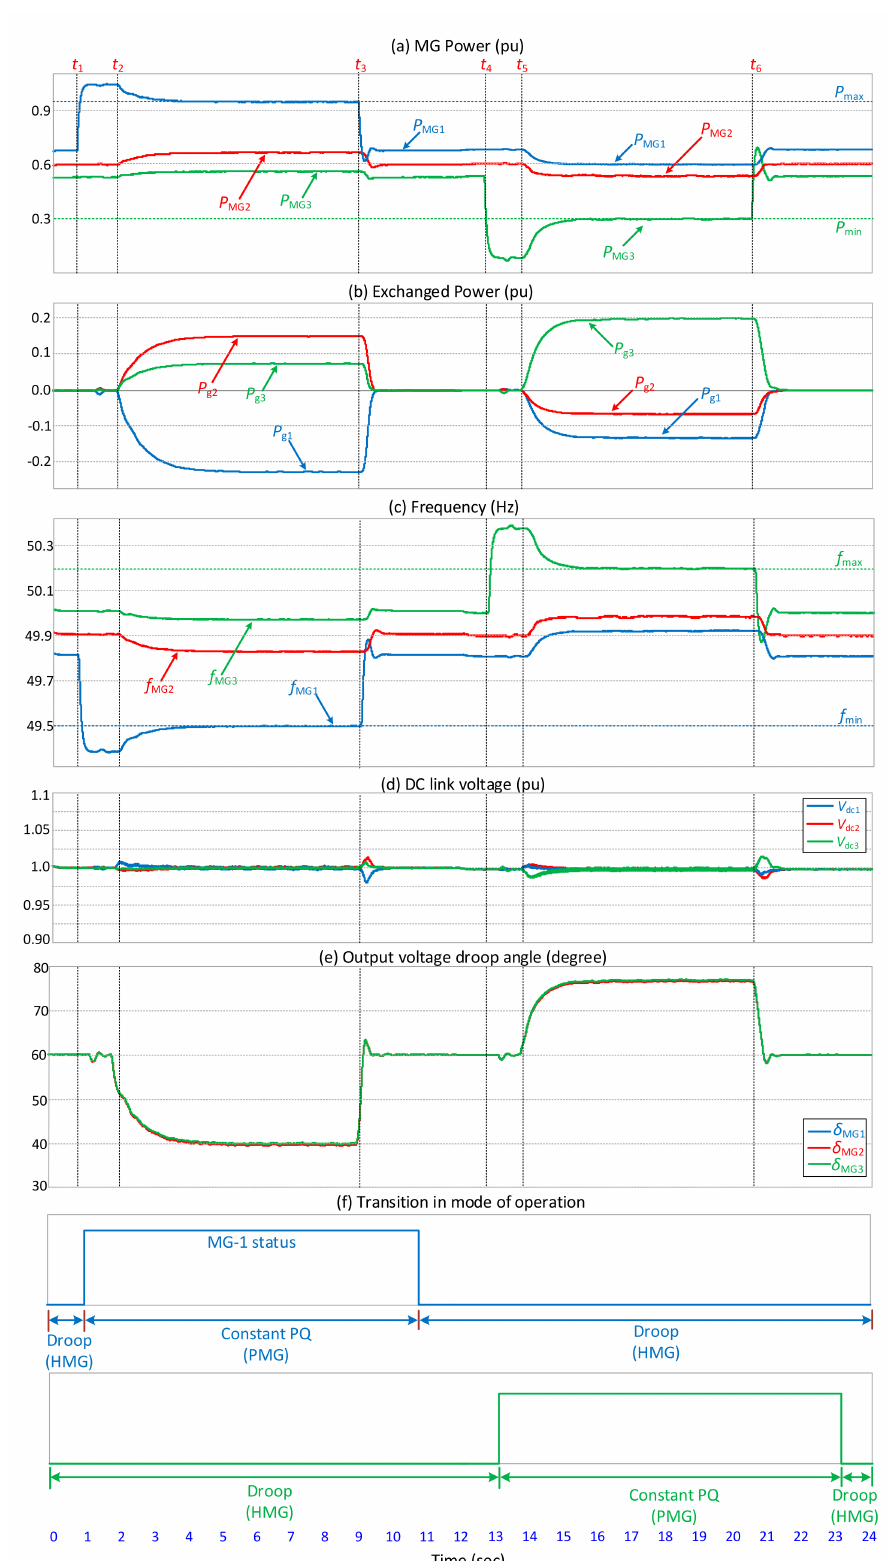
Figure 15. Simulation results of case study